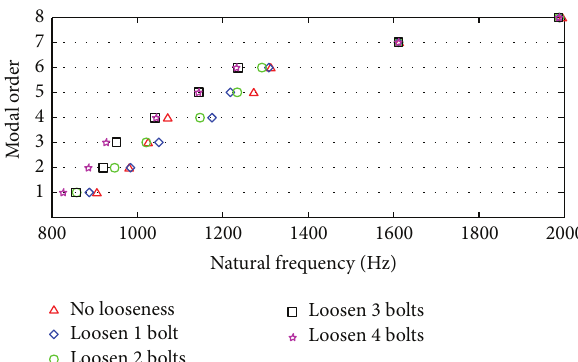
Figure 11: Scattergram of natural frequencies of TCS under BLB with different looseness numbers.